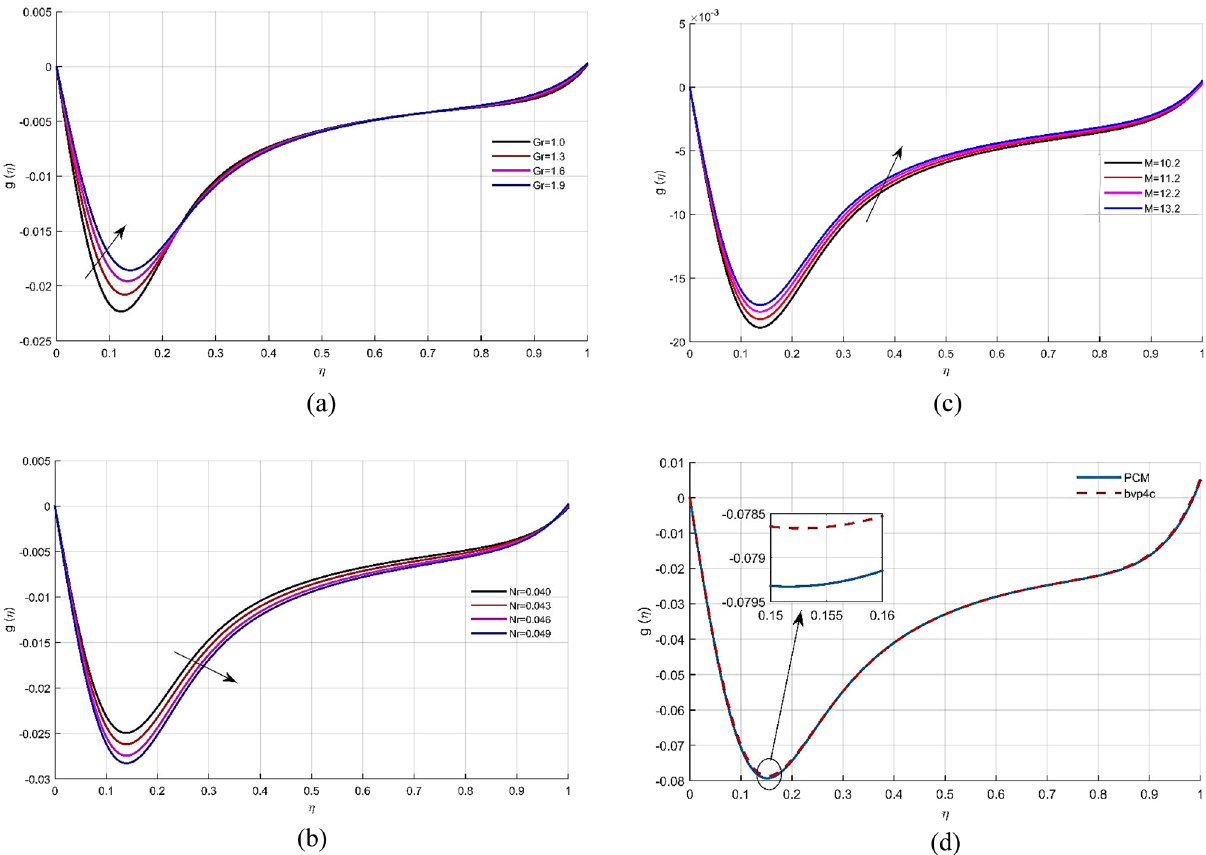
Figure 3. ( a – d ) Micro rotation profile g (η) under the effects of Gr , Nr and Mr . ( d ) Comparison of solution obtained by PCM and bvp4c